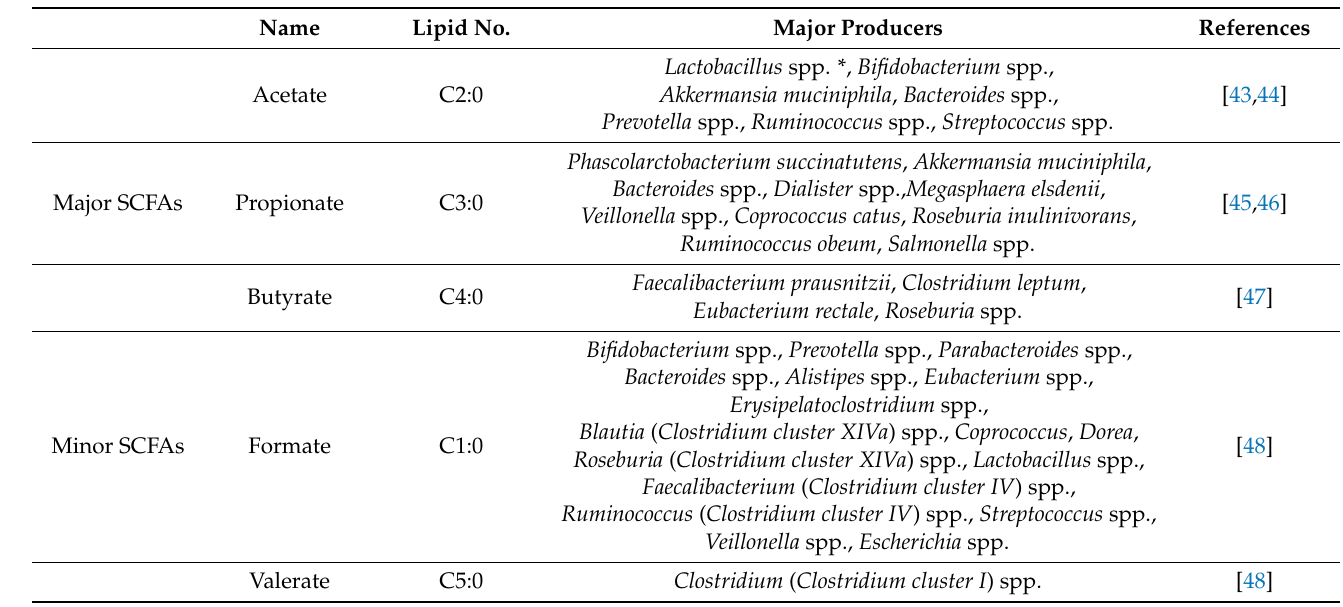
Table 1. Major and minor short-chain fatty acids (SCFAs) produced by the gut